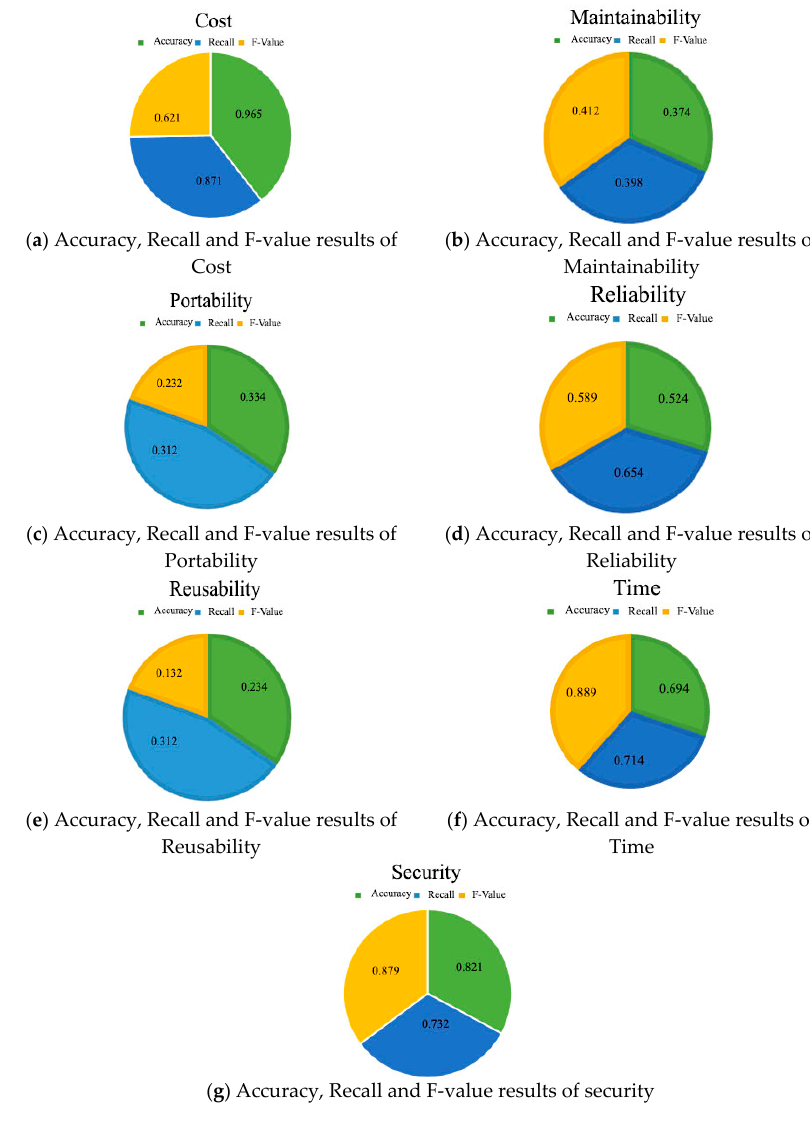
Figure 5. Recall and F ‐ value results of selected parameters .